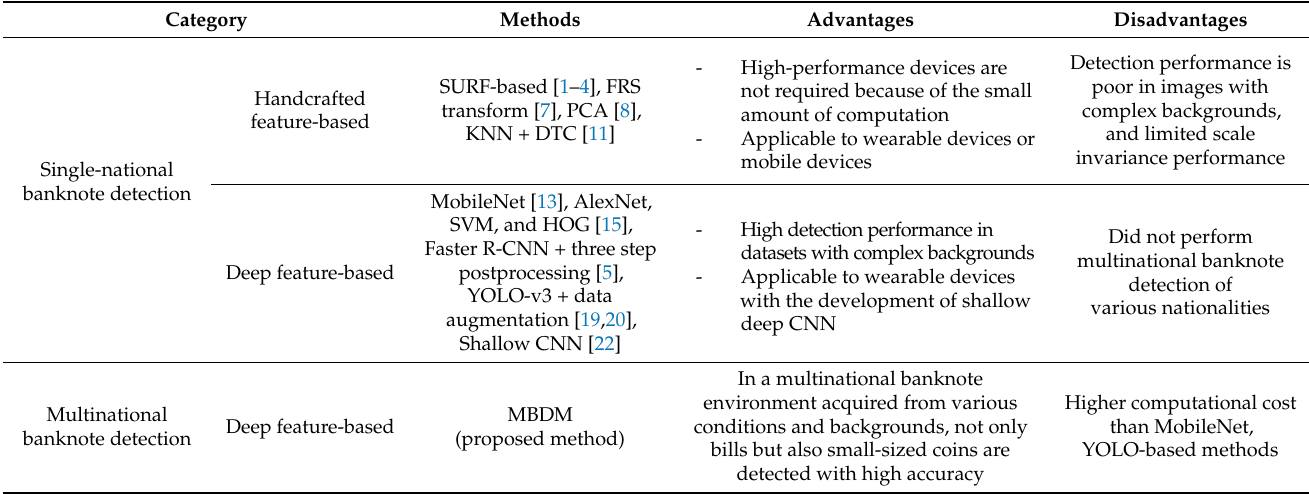
Table 1. Comparisons of proposed and previous studies on banknote